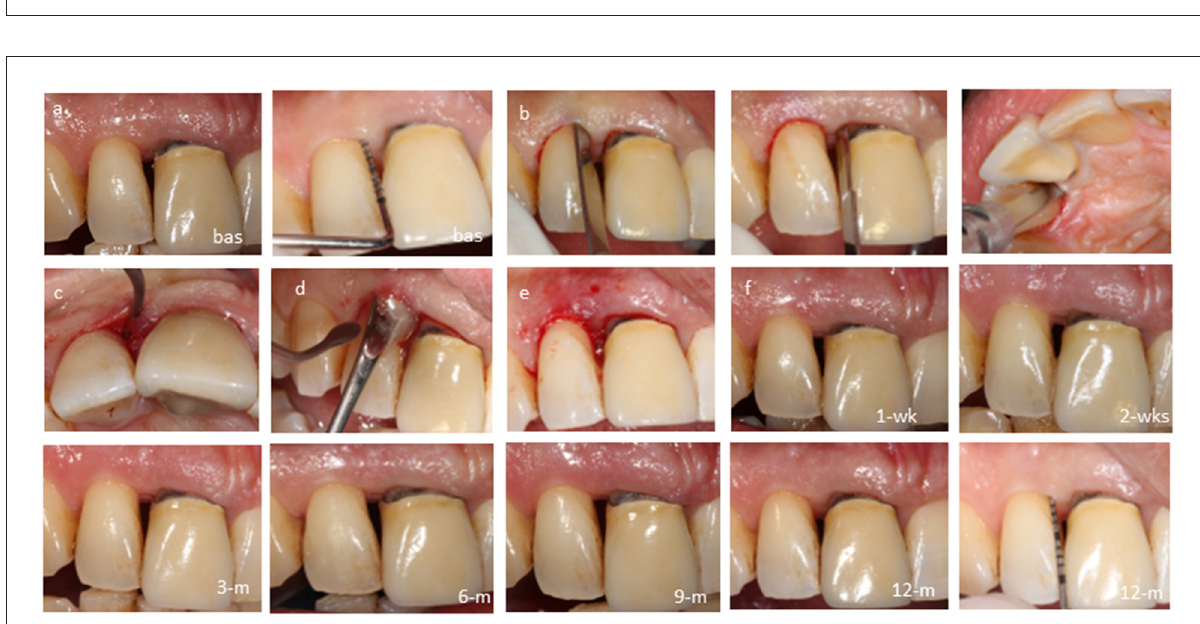
FIGURE5 Case-4, #12 mesial: (a) baseline probing before anesthesia; (b) intrasulcular dissection of the periodontal attachment; (c) closed retraction of gingival flaps including the papilla to gain access to the bottom of the defect; (d) biocomplex transplantation via the opening of the sulcus; (e) immediate post-operative view; crosslinked autologous fibrin platelet lysate by CaCl 2 seals the sulcus; (f) follow-ups at 1-, 2- weeks, 3-, 6-, 9- and